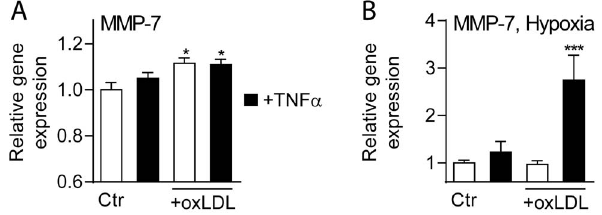
Figure 5. The regulation of MMP-7 expression in primary monocytes. Panel A shows the effect of oxLDL (20 m g/ml), TNF a (5 ng/ml) or a combination thereof, panel B shows the effect of hypoxia with or without co-stimulation with oxLDL (20 mg/ml), TNF a (5 ng/ml) or a combination thereof. The cells were cultured for 48 hours before experimental starts and cell pellets were harvested 18 hours thereafter. mRNA levels of MMP-7 were quantified by real-time RT-PCR in relation to the expression of the endogenous control gene b -actin. Data are mean 6 SEM (n=6) and are given in relation to cells that received vehicle (Ctr) or were cultured in normoxic condition. *p , 0.05 versus Ctr (panel A ). ***p , 0.001 versus all other conditions (panel B ).